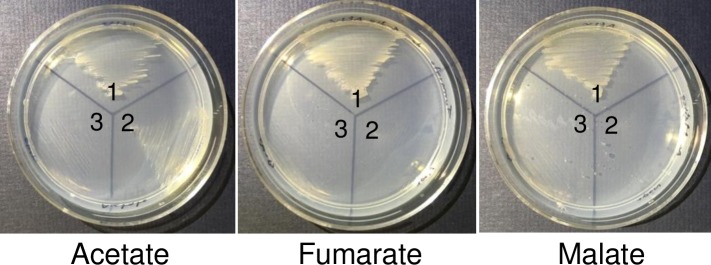
Growth of A. vinelandii strains on solid Burk’s medium.The wild type strain AEIV (1) and its isogenic RpoN- (2) and CbrB-null mutants (3) were cultured on plates of minimum Burk’s medium amended with 30 mM of acetate, fumarate or malate. The plates were incubated at 30°C /48 h.